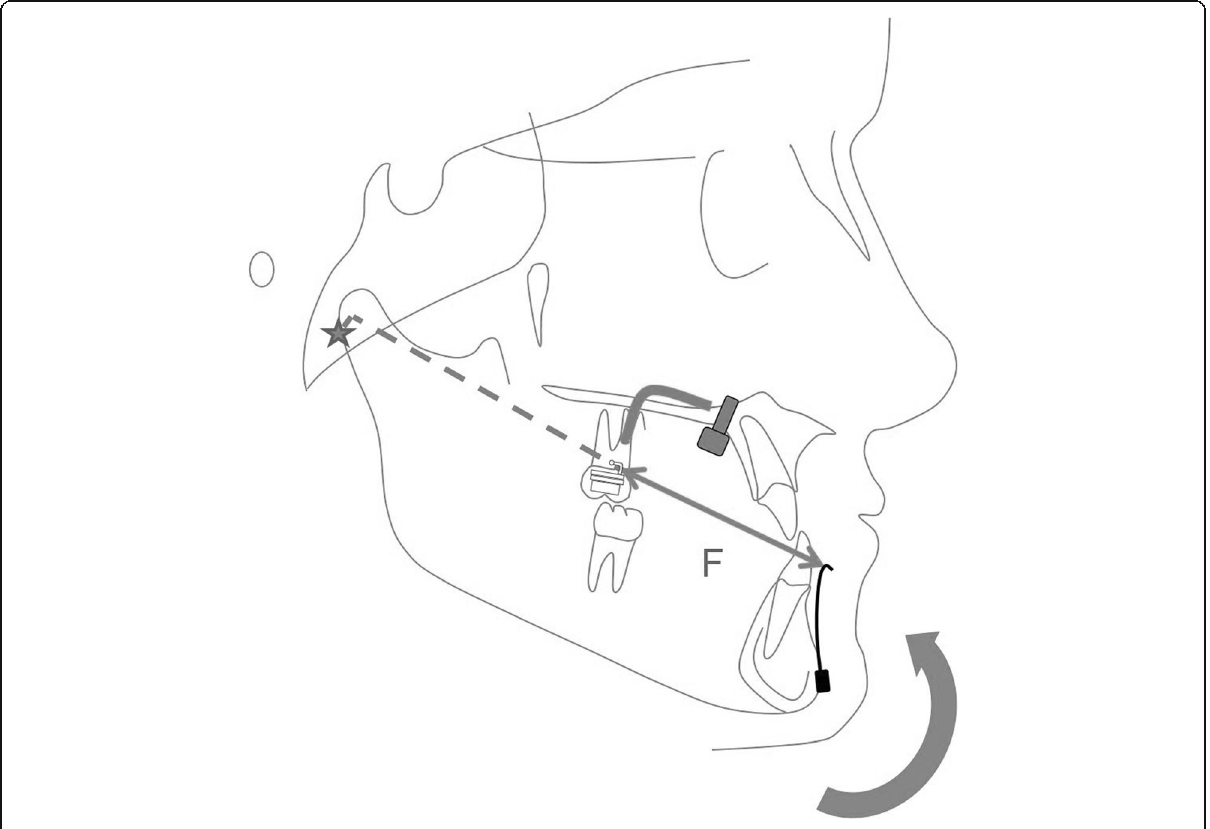
Fig. 4 Schematic diagram of the Mentoplate